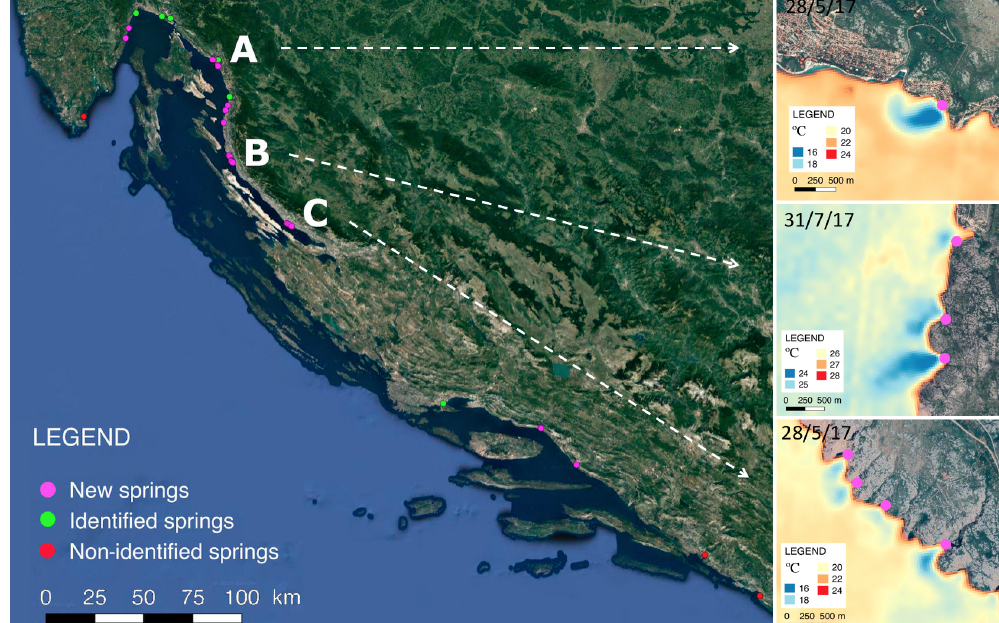
Figure 6. Springs reported in the literature (described SGD spring) vs. a new SGD spring identified with Landsat 8 TIRS. New SGD springs, not reported in the literature, are represented in pink. Springs reported in the literature are represented in green and white. © Google Earth